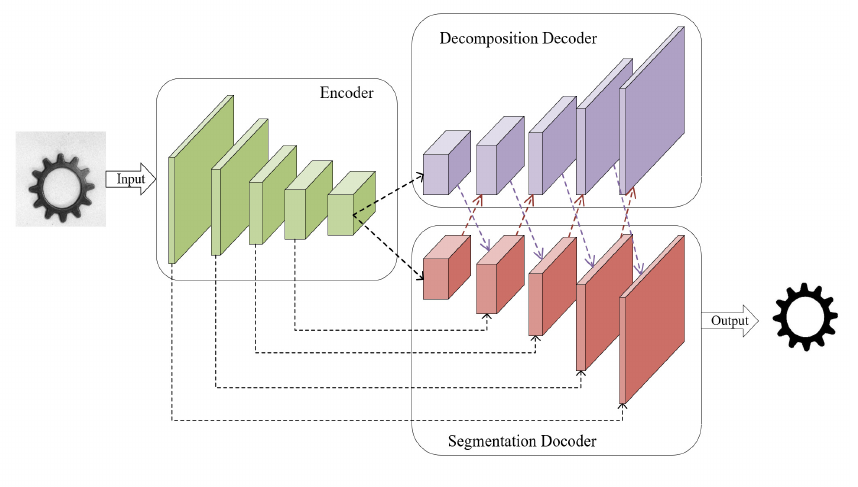
Figure 3. Model structure for joint